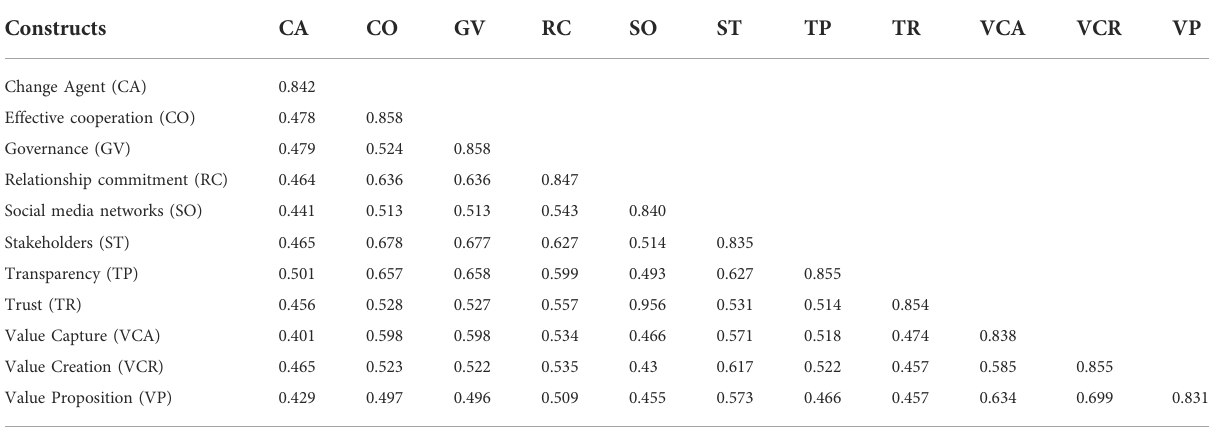
TABLE 6 Fornell-Larcker